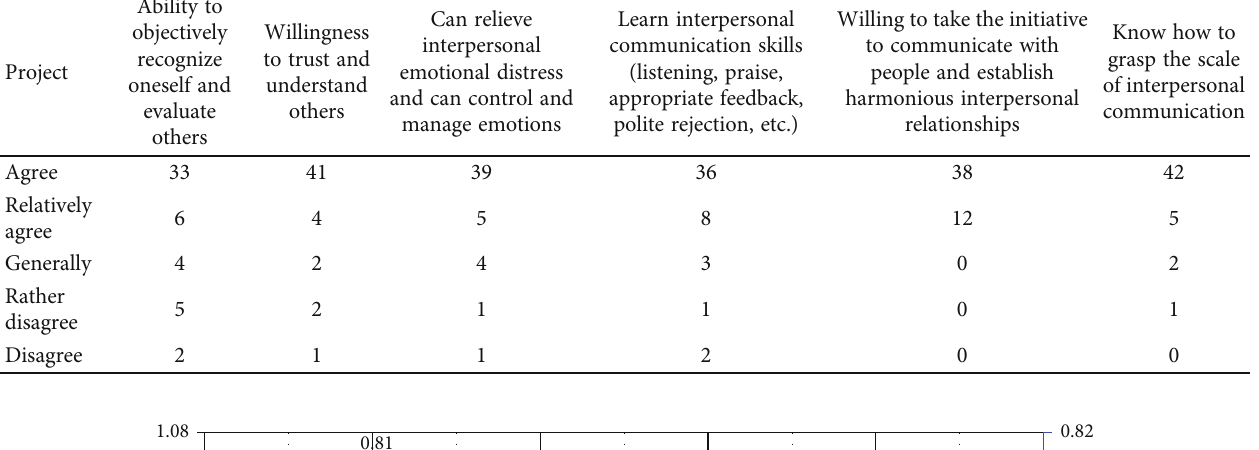
Table 1: Statistics of self-assessment of multivoice chorus e ff ect.